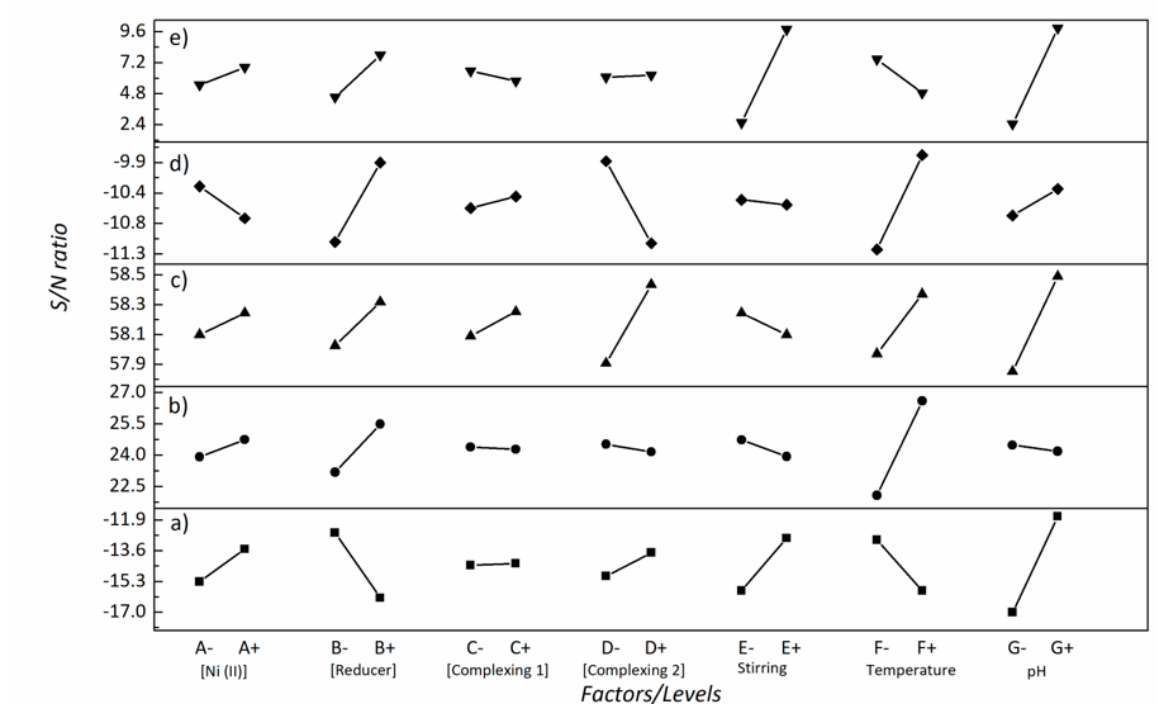
Table 2. Phosphorous content in the coatings obtained from L 8 experiments. “S.D.” stands for standard deviation.